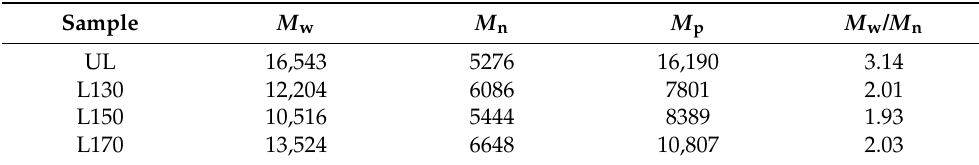
Table 2. Weight-average ( M w ) and number-average ( M n ) molecular weights and the polydispersity ( M w / M n ) of UL, L130, L150, and L170